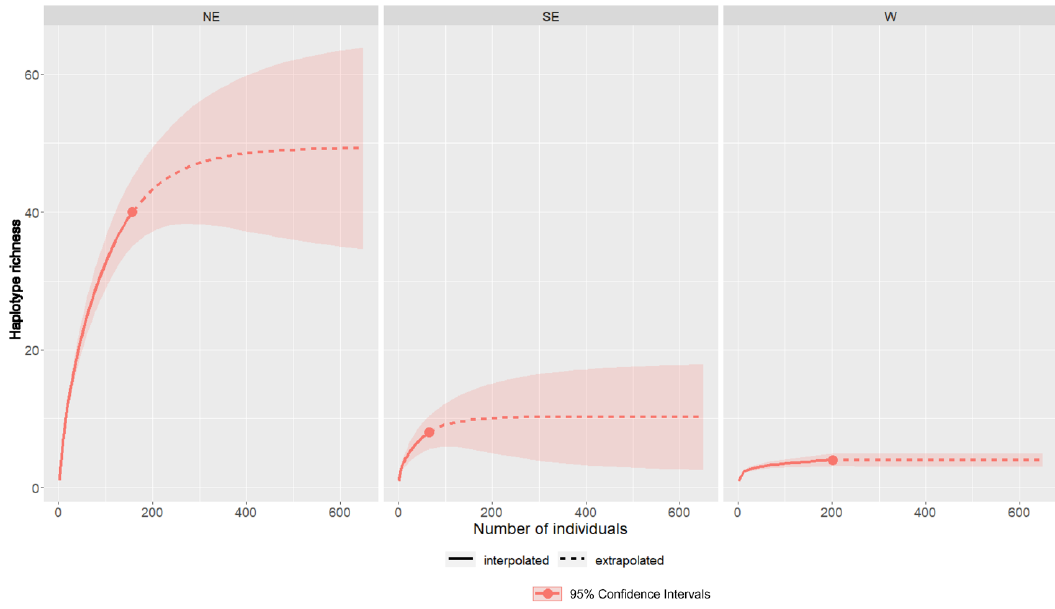
Figure 1. Sample-size-based refraction/extrapolation curves for three preserved populations (population abbreviations are as described in the main text) of European mink, plotting diversity estimates with confidence intervals as a function of sample size up to double the reference sample size (red dot indicates the interpolated haplotype richness, with the genetic data resources studied to date).